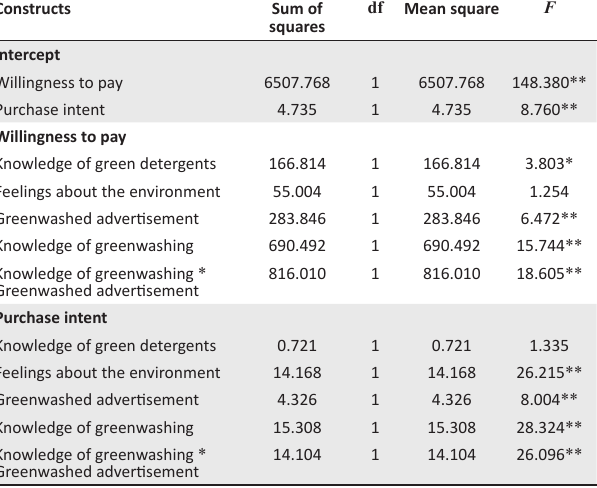
TABLE 2: Model explaining variance in Willingness to pay and Purchase intent .